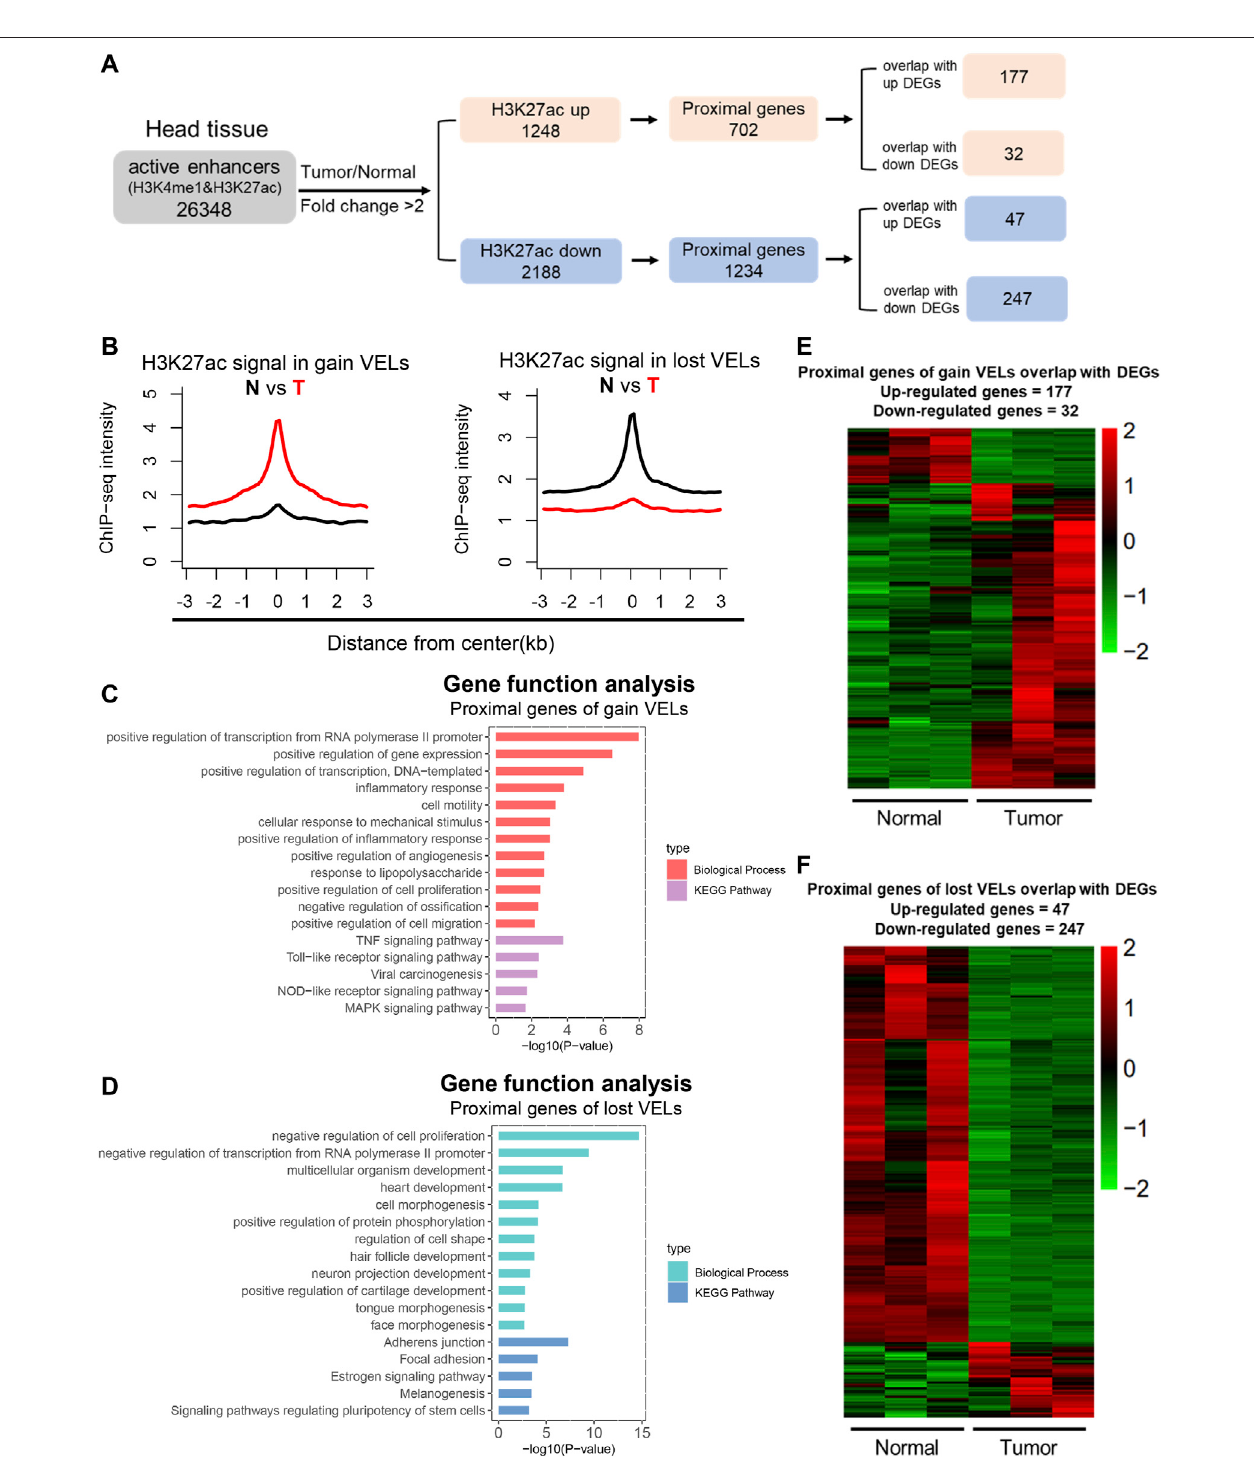
FIGURE 2 | Identi fi cation of variant enhancer loci in HNSCC. (A) A sketch map to show the pipeline of enhancer analysis. Active enhancers were de fi ned by H3K27ac and H3K4me1 and 2 kb away from TSS. (B) Aggregate plots comparing the mean H3K27ac signal (RPKM) across gain VELs and lost VELs in normal and tumor tissues. (C and D) Bar plots showed biological process and the KEGG pathway enrichment analysis of proximal genes for gain VELs and lost VELs, respectively. Items were ordered by the p value. (E and F) Heat maps showed the expression level of proximal genes of VELs overlapped with DEGs. ( n (cid:1) 3).